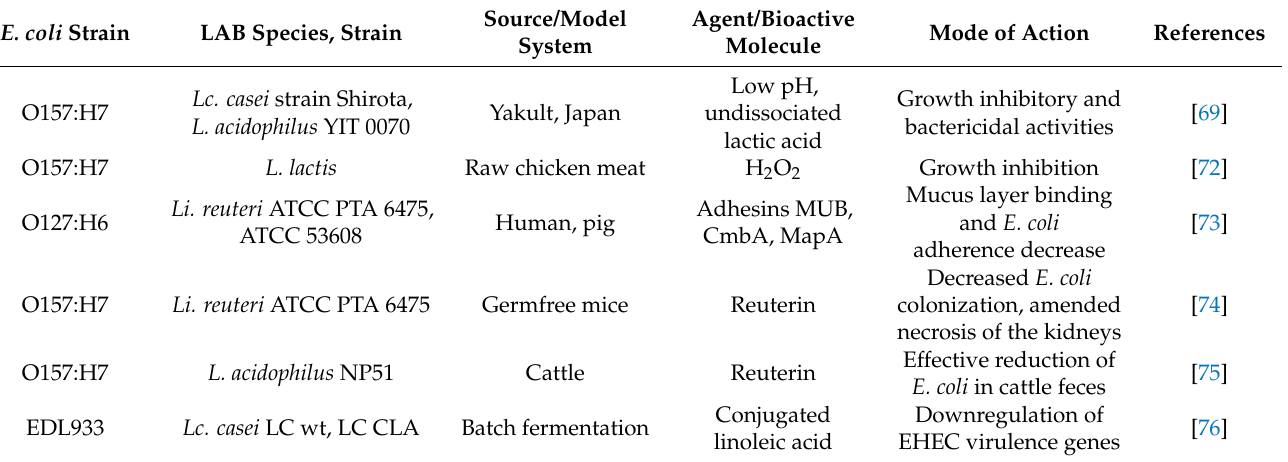
Table 1. Established mechanisms of antibacterial activity of lactic acid bacteria (LAB) against toxigenic E. coli